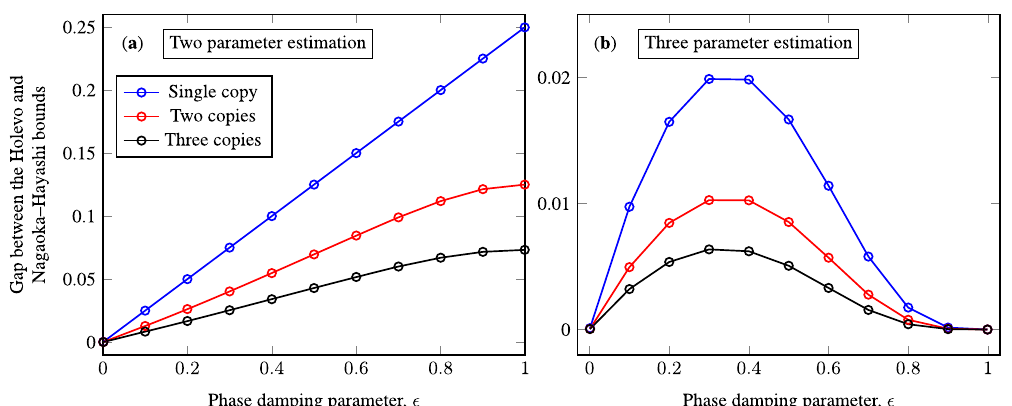
Fig. 2 Estimating multiple parameters with collective measurements on fi nite copies of the probe state. Both fi gures show how the gap between the Holevo and Nagaoka – Hayashi bounds shrinks as the number of copies of the probe state increases for estimating two ( a ) and three ( b ) parameters. The Nagaoka – Hayashi bounds are rescaled by the number of copies of the probe state to account for the resources used.